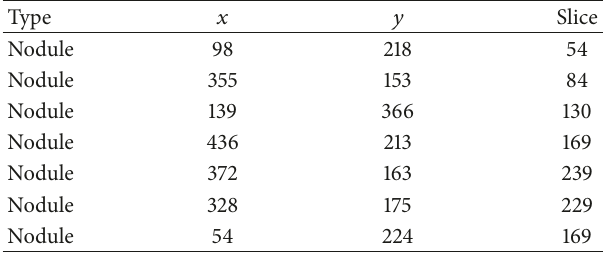
Table 1: Format of lung nodule